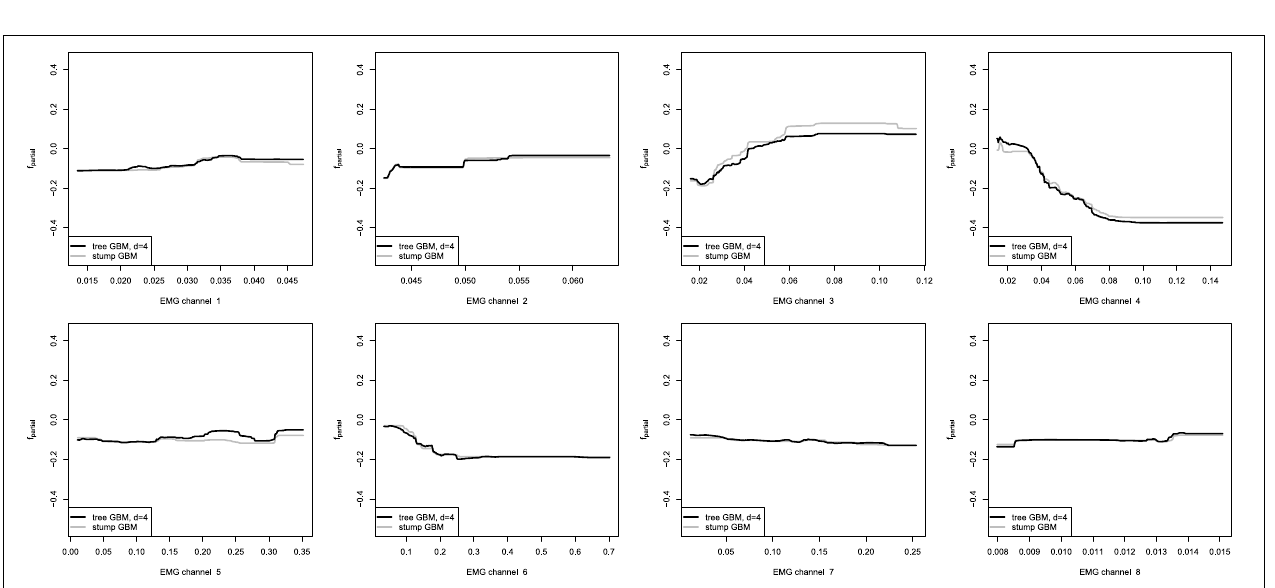
FIGURE 9 | Partial dependence plots for tree-based GBMs on the EMG robotic control data. The gray line corresponds to the stump-based GBM; the black line corresponds to the tree-based GBM with interaction depth d = 4.